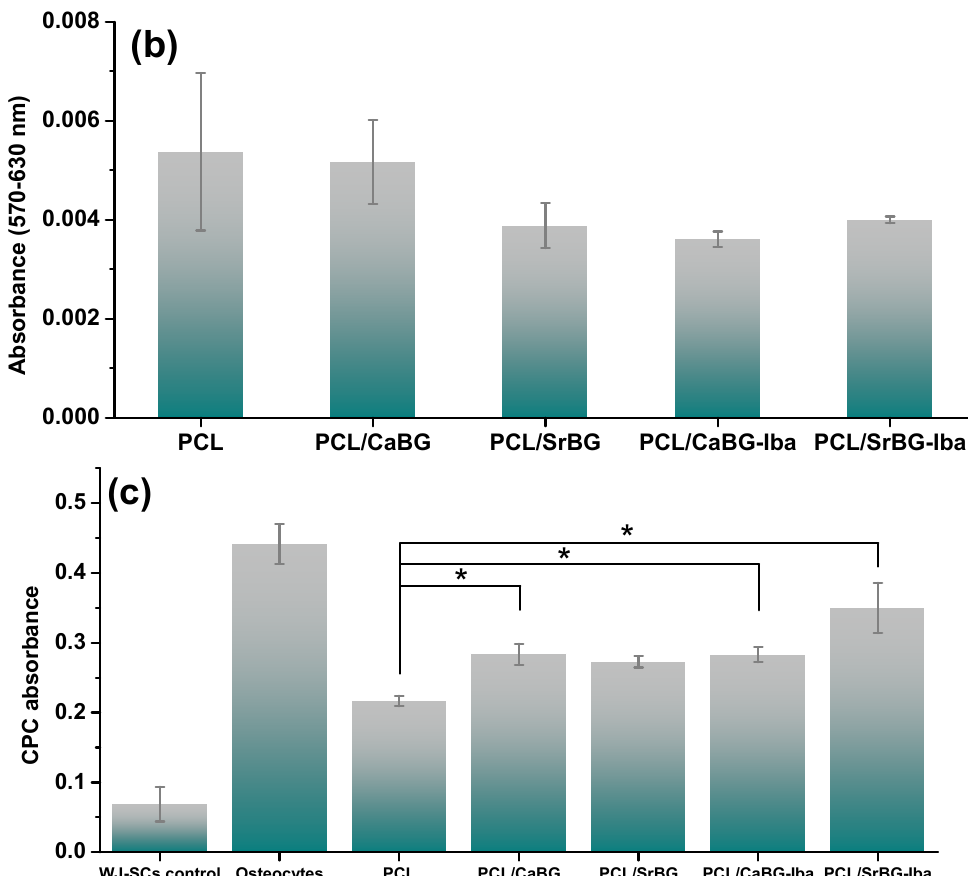
Figure14. ( a )Fluorescencemicroscopyimagesofgeneticallymodified WJ-MSCsonthePCLmembranes, Figure 14. ( a ) Fluorescence microscopy images of genetically modified WJ-MSCs on the PCL ( b ) MTT assay results of WJ-MSCs cells after seeding for 24 h on PCL and its nanocomposites and ( c ) membranes,( b ) MTT assay results of WJ-MSCs cells after seeding for 24 h on PCL and its assessment of osteogenic di ff erentiation by cetylpiridinium chloride (CPC) method after 28 days in the nanocomposites and ( c ) assessment of osteogenic differentiation by cetylpiridinium chloride (CPC) induced-di ff erentiation culture 30 days culture. *: p < method after 28 days in the induced-differentiation culture 30 days culture. *: p < 0.05.